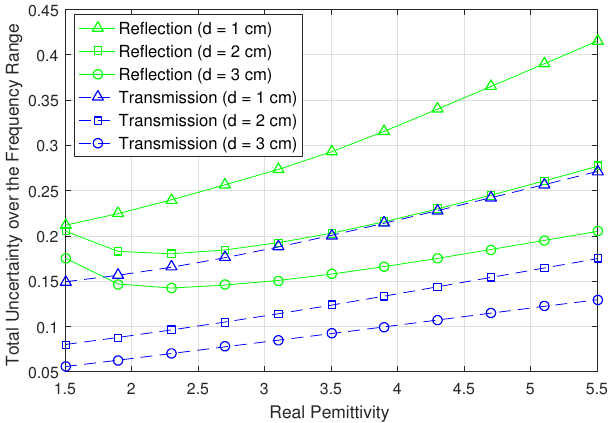
Figure 12. Total uncertainty over frequency ∆ ε r f thicknesses d and ε (cid:48) r . The different markers distinguish the thickness d